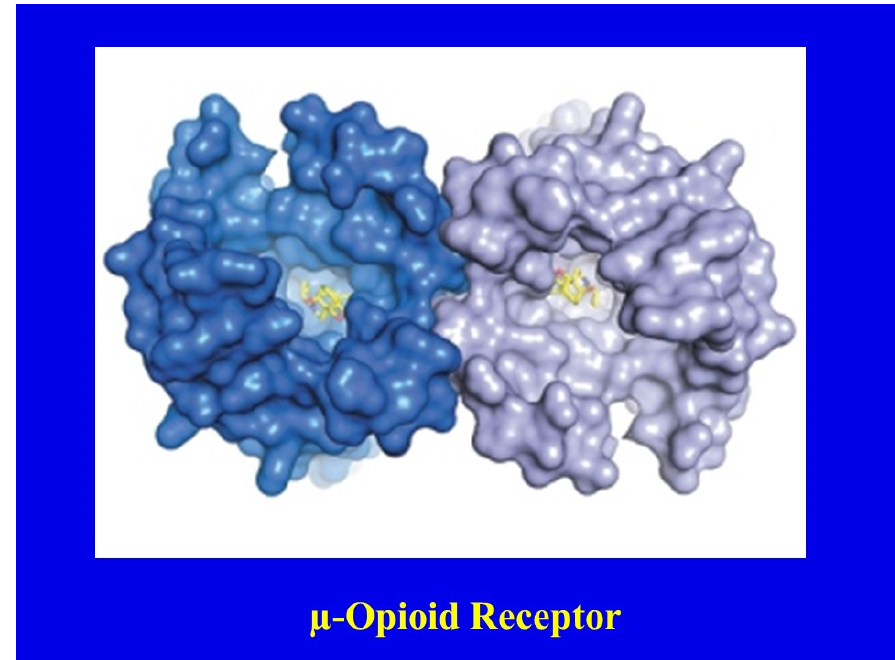
Figure 5. Helical structure of the μ -opioid receptor. Reproduced with permission from Manglik, A.; Nature ; published by Nature Publishing Group, 2012 [24].